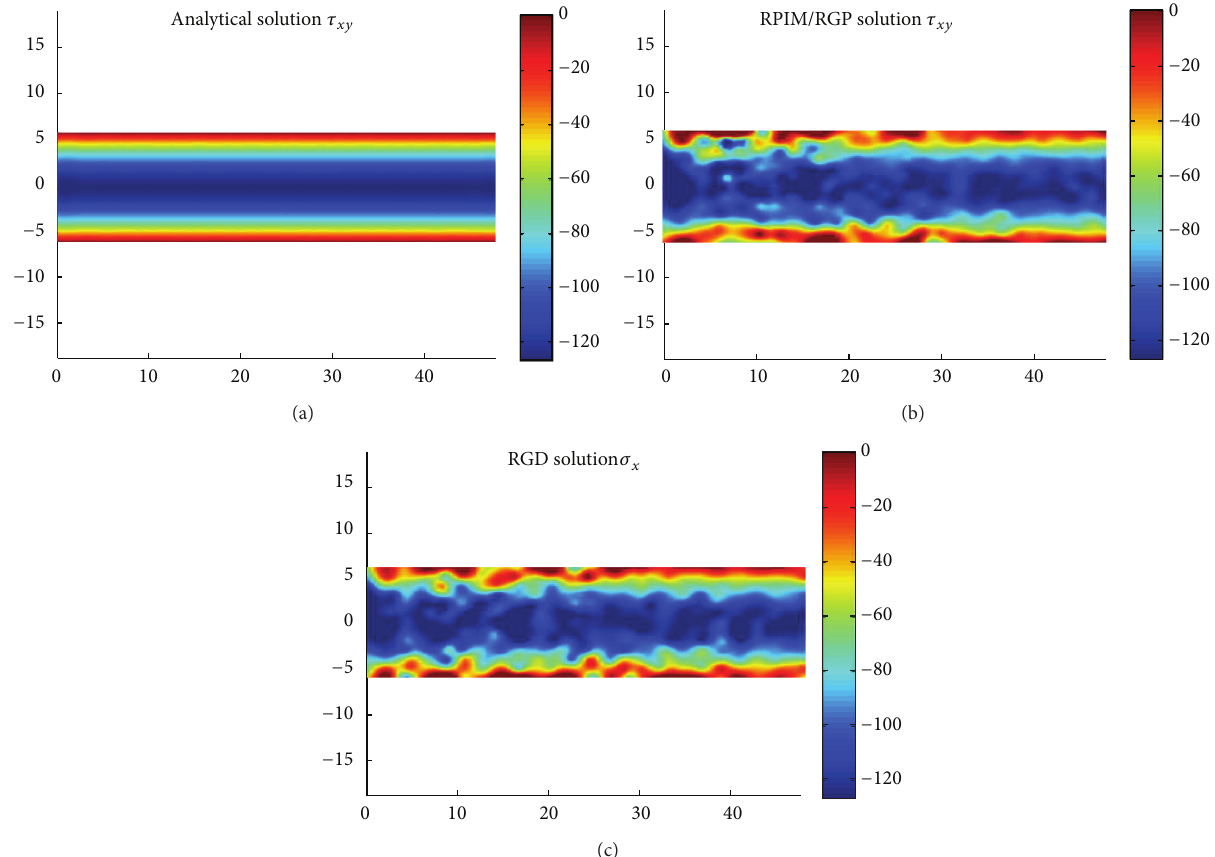
Figure 9: Shear stress 𝜏 𝑥𝑦 : analytical results (a), RGP numerical results (b), and RGD numerical results (c).